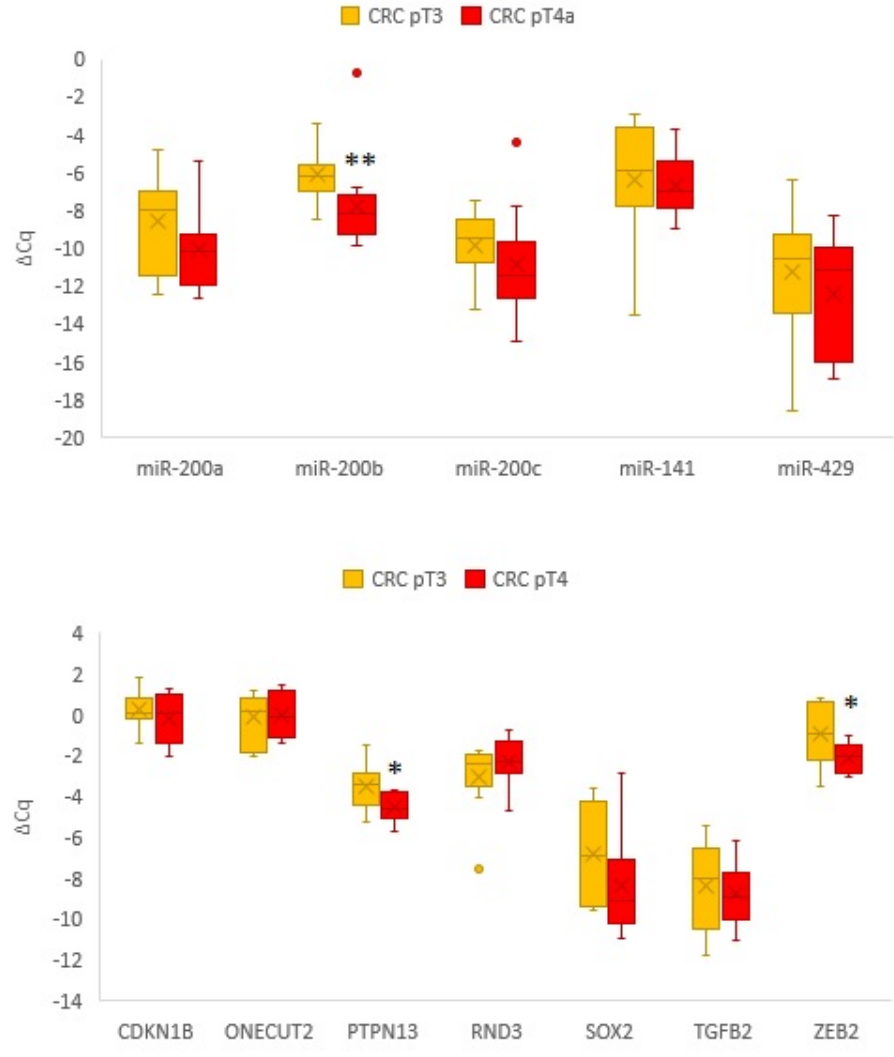
Figure 3. Expression of the miR-200 family and their target genes in CRC pT4a in comparison to CRC pT3. Abbreviations: CRC, colorectal carcinoma; ∆ Cq, delta cycle of quantitation; pT3 and pT4a, pathological stage T3 and T4a, respectively, according to pathologic tumour–node–metastasis classification [25]; *, p < 0.05; **, p < 0.01.